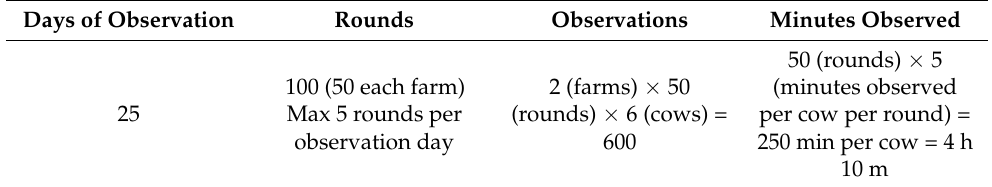
Table 1. A summary of the number of days, rounds, observations and minutes the cows were observed for data collection during the first part of the study (horn temperature in relation to behaviour and